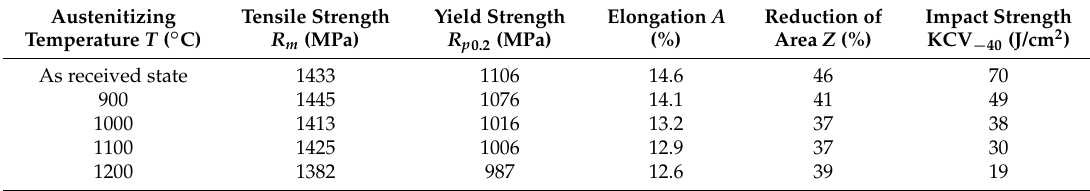
Table 3. Selected mechanical properties of tested steel after austenitizing at different temperature.